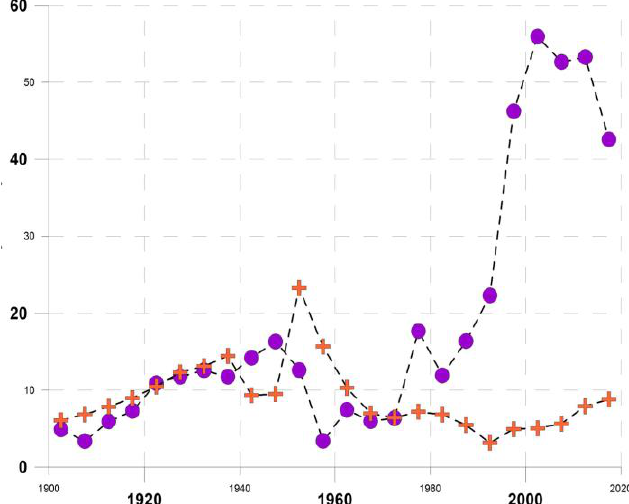
Fig. 3. The northern component of the velocity of geomagnetic dipole poles in the northern (balls) and southern (crosses) hemispheres was estimated using the WGS84 spheroid